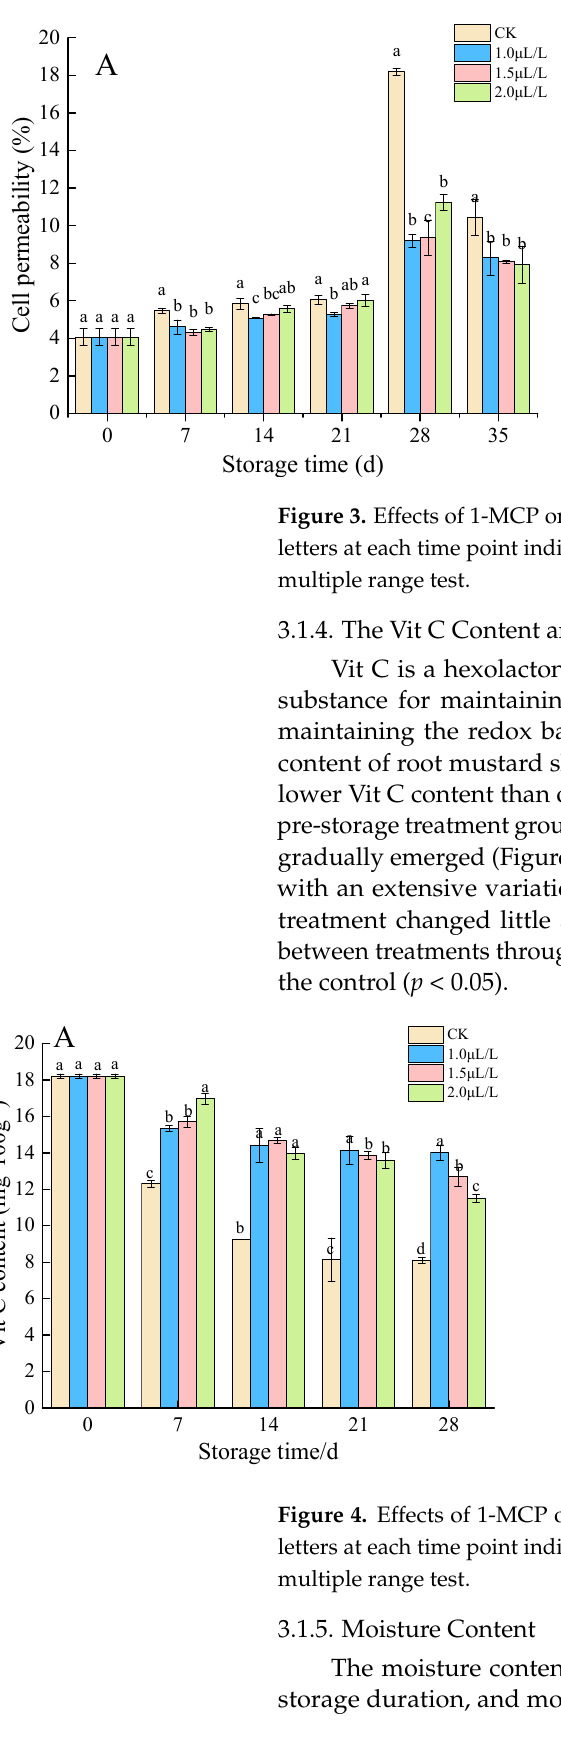
Table 1. Effect of 1-MCP on moisture content of root mustard.